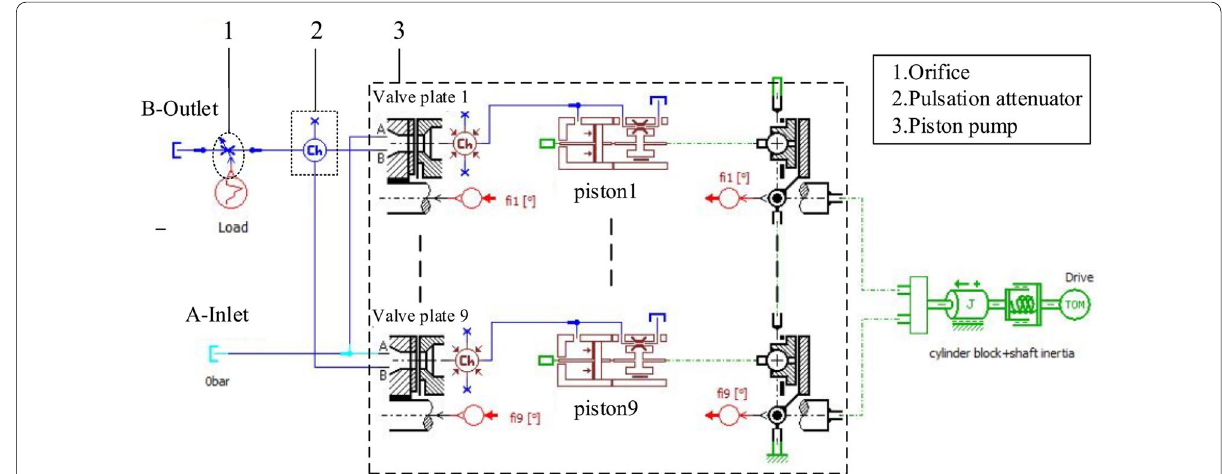
Figure 25 One-dimensional simulation model of nine-piston pump